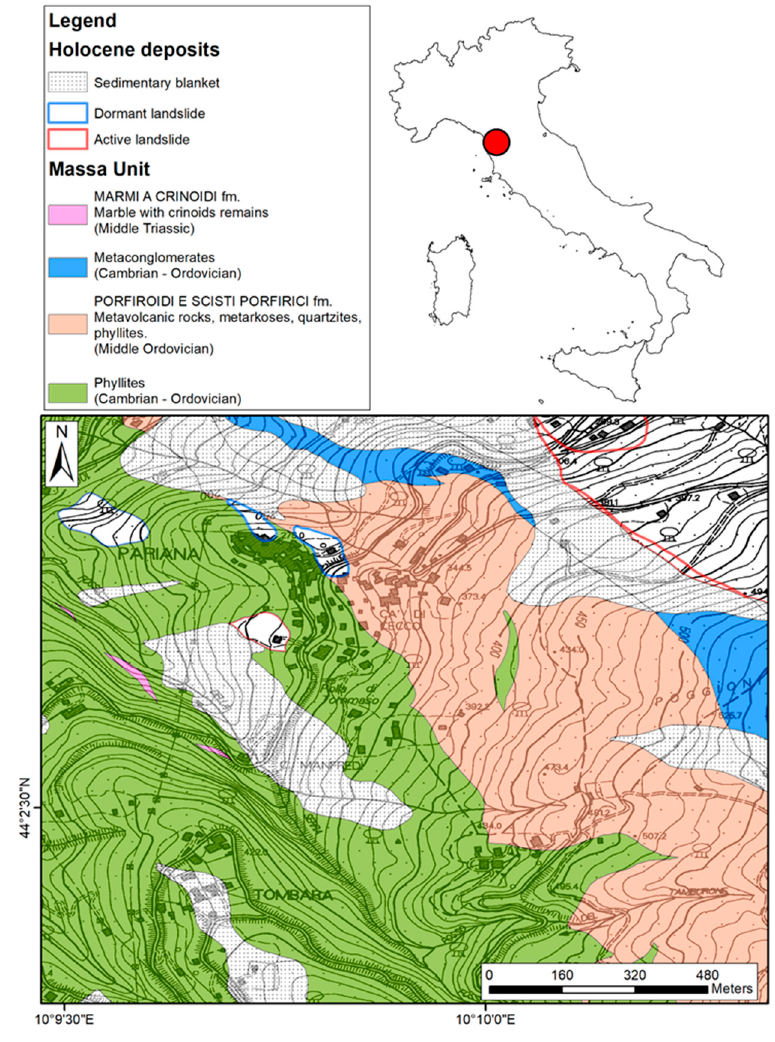
Figure 1. Location and geological map of the study area.